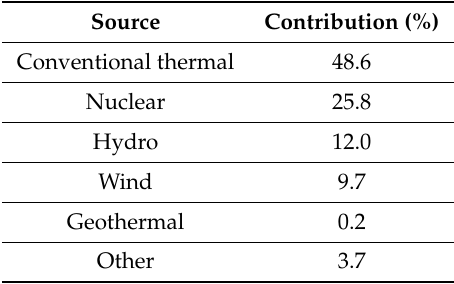
Table 1. Contribution of sources in EU-28 in 2016 [31].